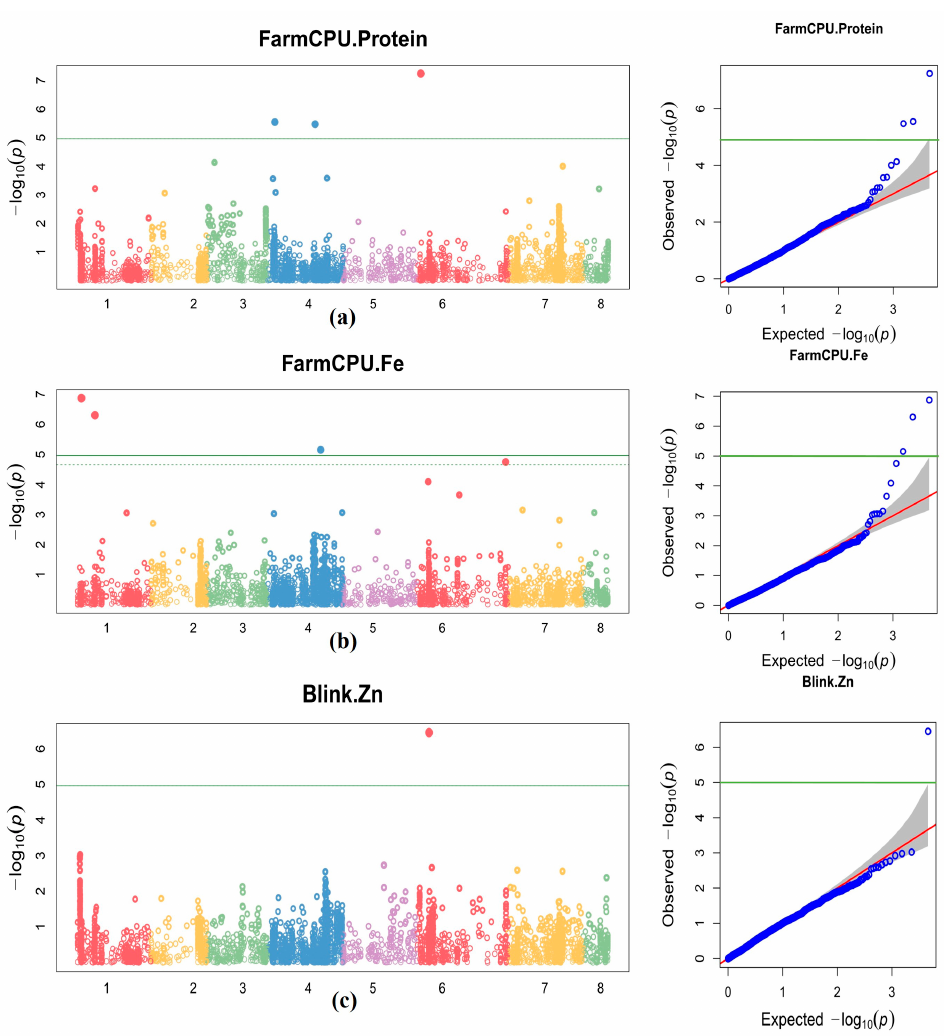
Figure 5. Manhattan plots illustrated significant p -value associated with grain protein and Fe in chickpea under NSII by FarmCPU ( a , b ) and Zn (NSI) BLINK ( c ) models. Dotted line, suggestive MTAs at FDR cutoff p < 0.05; Fe, grain iron content; Zn, grain zinc content; NS, normal season.